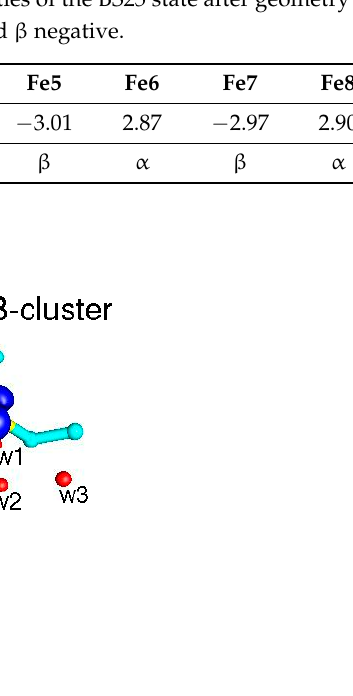
Figure 5. The BS25 spin density distribution on Fe atoms after geometry optimization. Up spin α /+ is shown in blue, while β / − is shown in red. Sulfur atoms are colored yellow, carbon atoms cyan, nitrogen atoms blue, and oxygen atoms in red. Hydrogen atoms are omitted for clarity. Figure drawn using gopenMol and TGIF. Table 1. Electronic state analysis of the spin densities of the BS25 state after geometry optimiza ‐ tion. α is conventionally indicated as being positive and β negative.